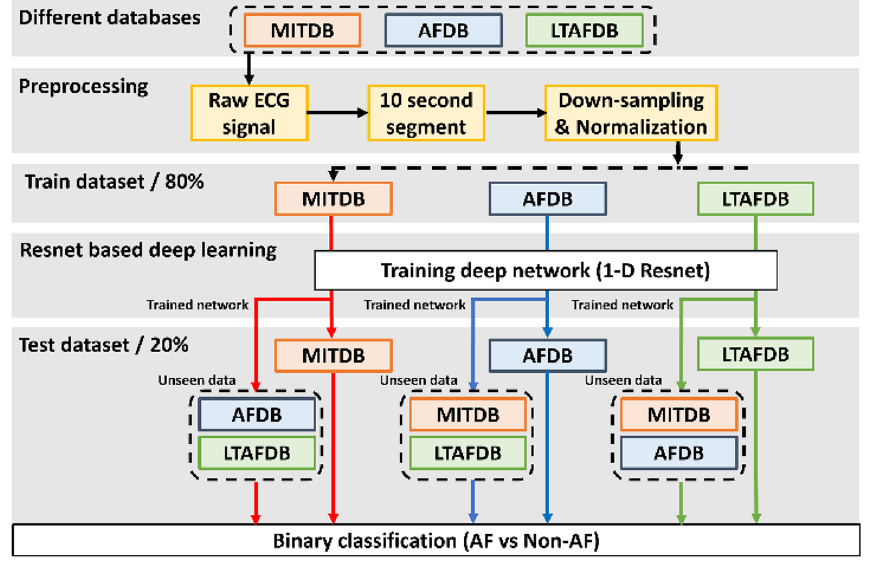
Figure 1. Overview of our